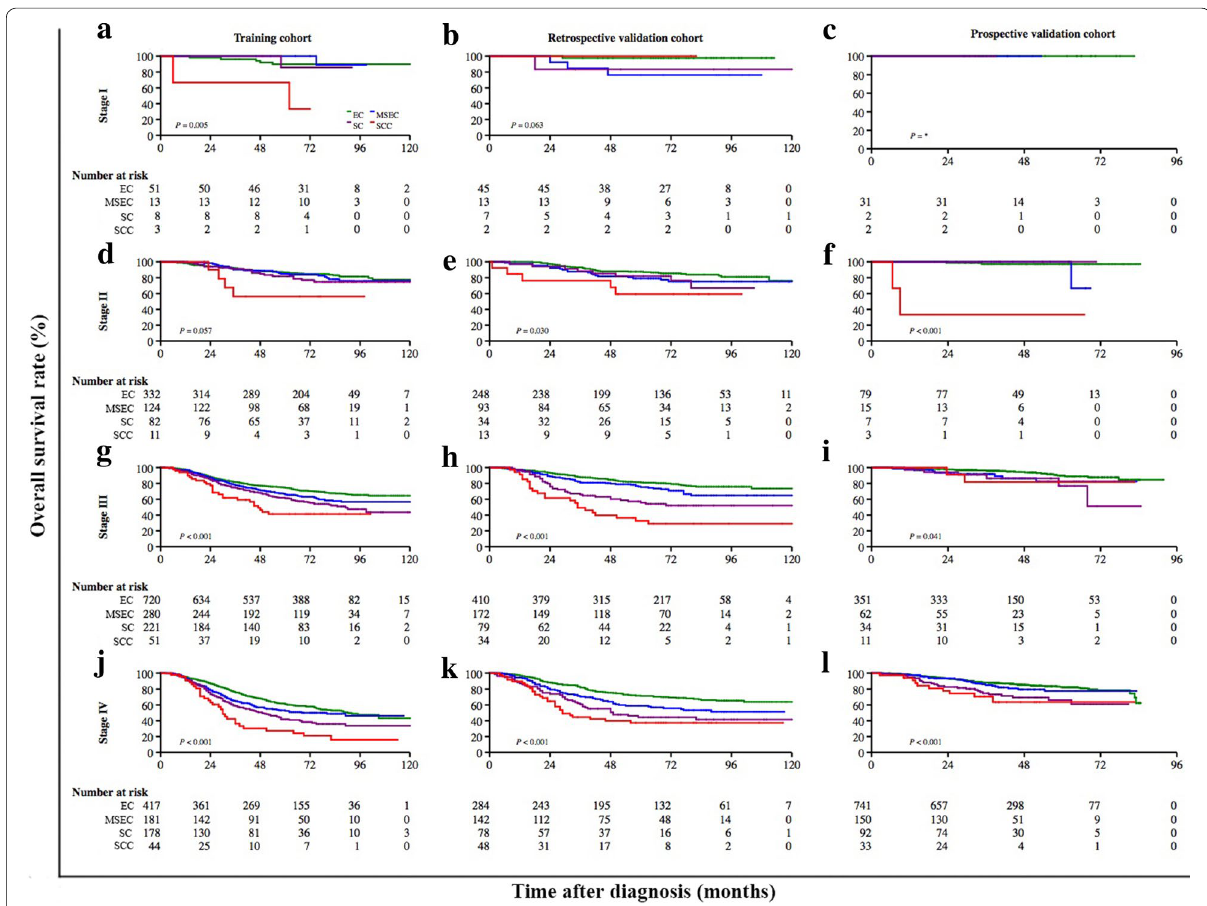
Fig. 7 Kaplan‑Meier survival estimates for NPC patients at different clinical stages in three separate cohorts stratified by subtypes according to the proposed classification. OS curves of NPC patients stratified by subtypes according to the proposed classification with stage I ( P ( P 0.063, b ; c ), II ( P 0.057, d ; P 0.030, e ; and P < 0.001, f ), III ( P < 0.001, g and h ; P = = = retrospective validation, and prospective validation cohorts, respectively. The log‑rank test was used to calculate P values. *No test possible